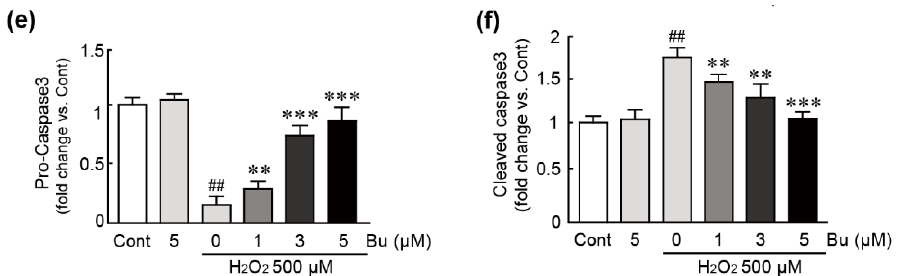
Figure 3. Butein attenuates apoptotic cell death in H 2 O 2 -treated H9c2 cardiomyoblasts. The cells were treated with butein and/or H 2 O 2 ( a ) Nuclear staining was performed by Hoechst staining. The arrow indicates apoptotic cells with nuclear condensation using cells that were treated with butein and/or H 2 O 2 . The cells in at least 10 fields (30 cells per field) were counted in each group. ( b ) The percentage of apoptotic cells versus total cells is shown as the apoptotic index. ( c ) Western blot analysis for the expression levels of apoptosis-related proteins including Bcl-2, Bax, pro- and cleaved caspase 3, and β -actin (loading control). The band densities of the ratio of Bcl-2/Bax ( d ) and pro- ( e ) and cleaved ( f ) caspase 3 proteins were calculated with HD imaging software. The results are shown as the mean ± SEM in triplicate. # p < 0.05 and ## p < 0.01 vs. control group. ** p < 0.01 and *** p < 0.001 vs. H 2 O 2 -only group. Cont; control, Bu; butein. Scale bar, 100 µm.